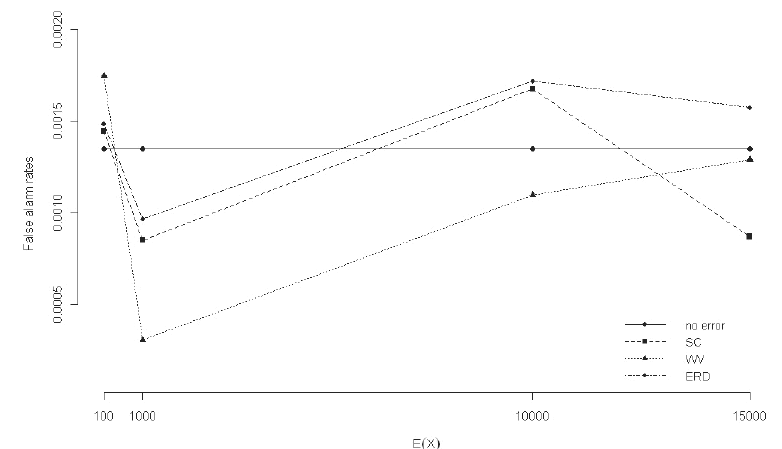
Figure 3 – False alarm rates below the LCLs.